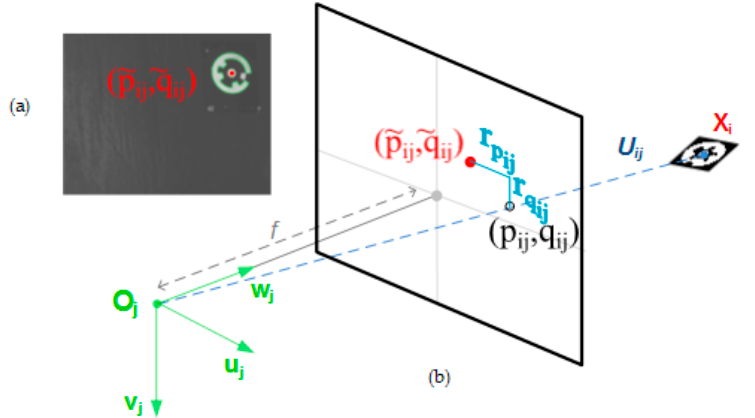
Figure 5. Target 2D detection and conic projection through epipolar line. ( a ) Example of optical target coordinate detection ( (cid:101) p ij and (cid:101) q ij ) at image plane; ( b ) Conic projection ( p ij and q ij ) into image plane of the target 3D coordinate X i according to epipolar line from O j camera frame ( R j and d j ), with the corresponding projection error contribution ( r p and r q ) to the joint residual ij ij